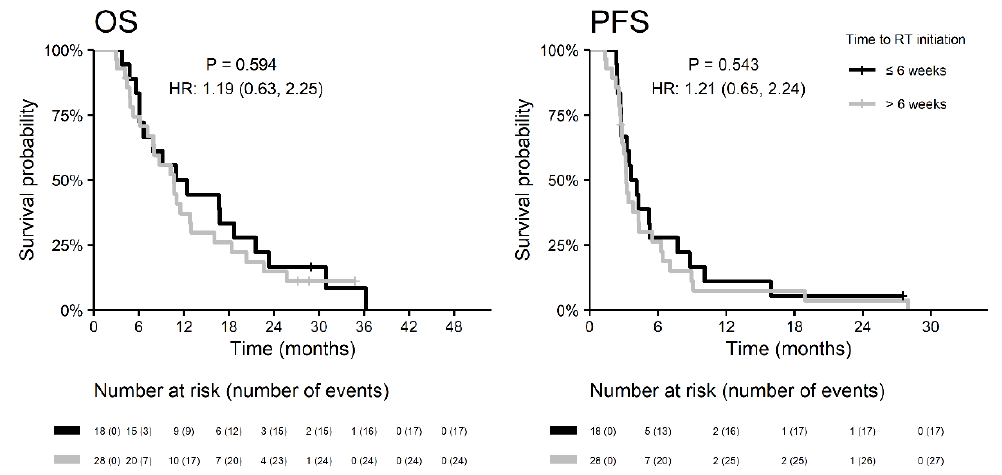
Figure 5. Survival outcomes of patients with REP in relation to the start of radiotherapy.